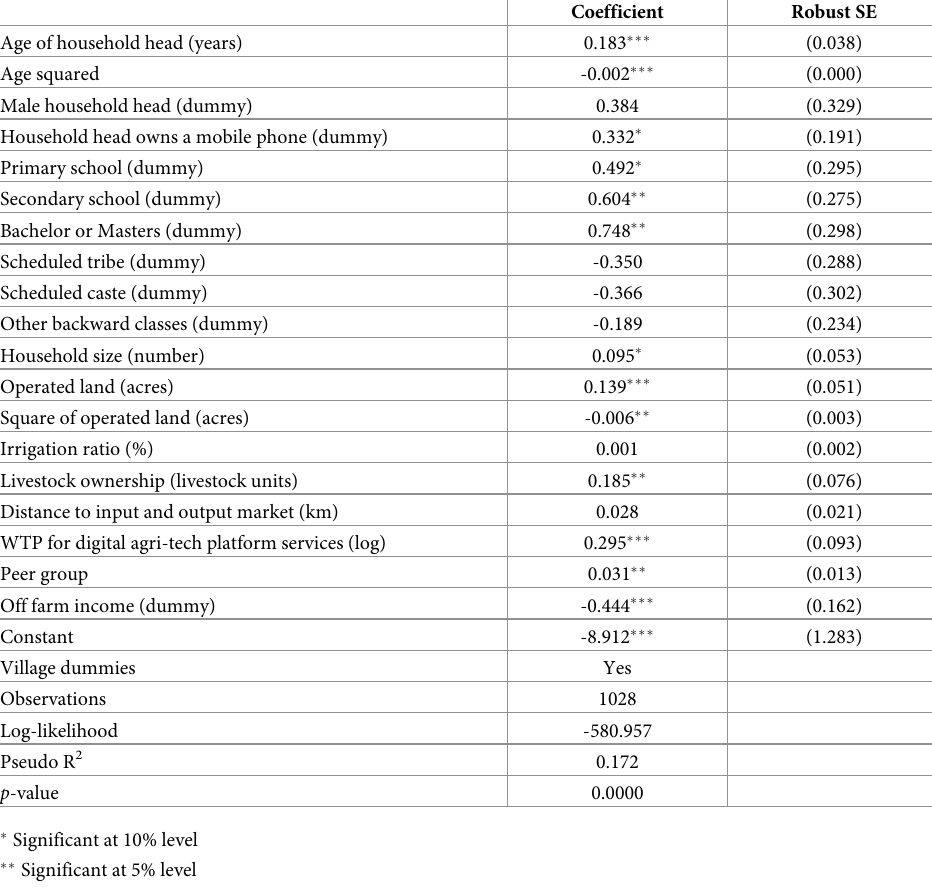
Table 3. Logit estimates of the propensity to adopt digital extension